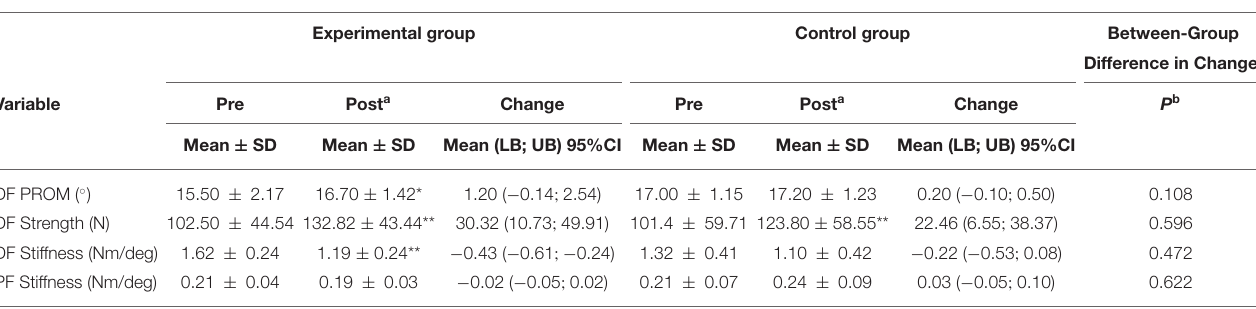
TABLE 2 | Biomechanical Properties at pre- and post-training between two groups.